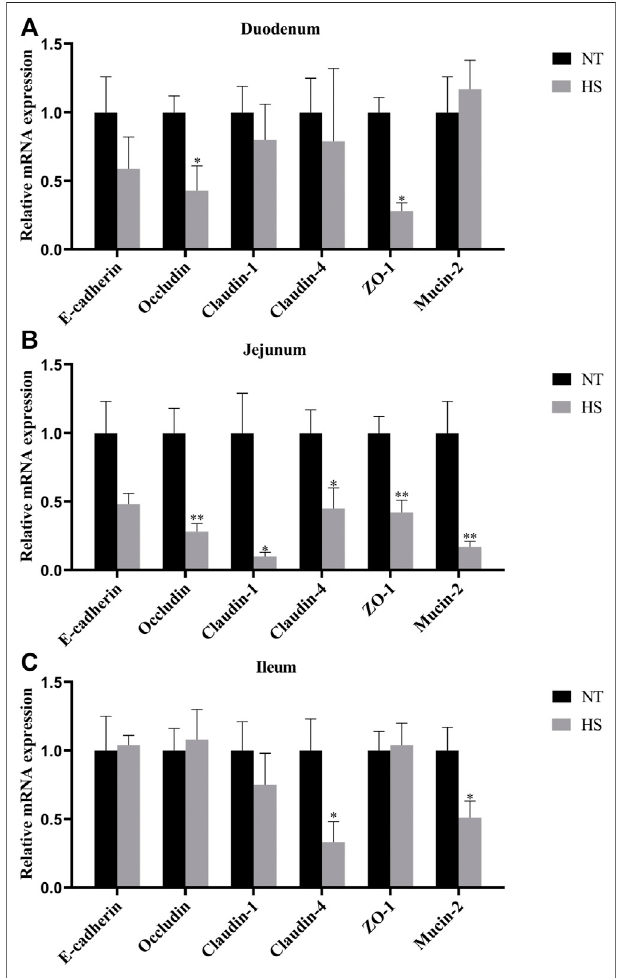
FIGURE3| Effects ofheatstressonrelative mRNAexpression ofbarrier function-related genes of duodenum (A) , jejunum (B) and ileum (C) in indigenous broilers (n = 5/group). NT, normal treatment group (21.3 ± 1.2 ° C, 24 h/day), HS, heat stress group (32.5 ± 1.4 ° C, 8 h/day). * p < 0.05, ** p <